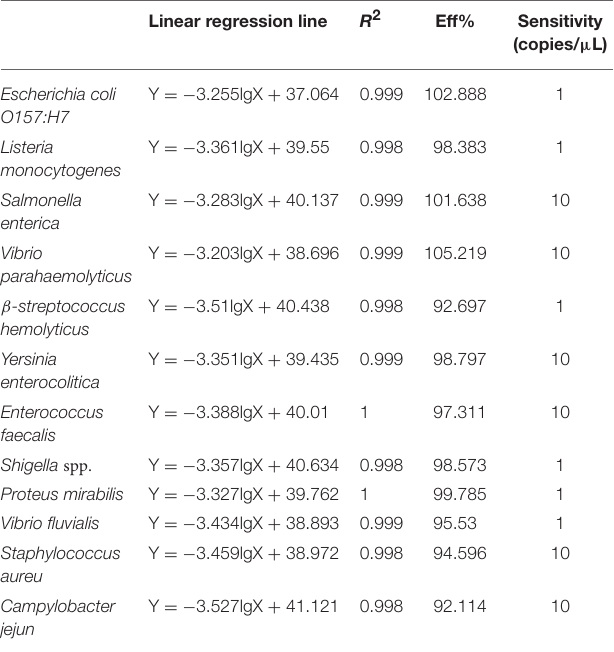
TABLE 3 | Sensitivity and efficiency of the TaqMan real-time PCR obtained by series of 10-fold dilutions of the Standard plasmid. Linear regression